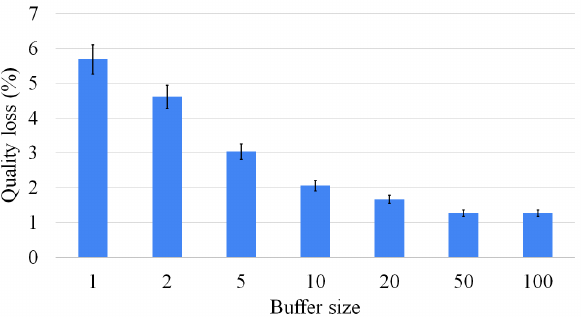
Figure 15. The tree approach: Quality loss (on the y-axis) as a function of the number of intermediate solutions considered (on the x-axis), varying from 1 to